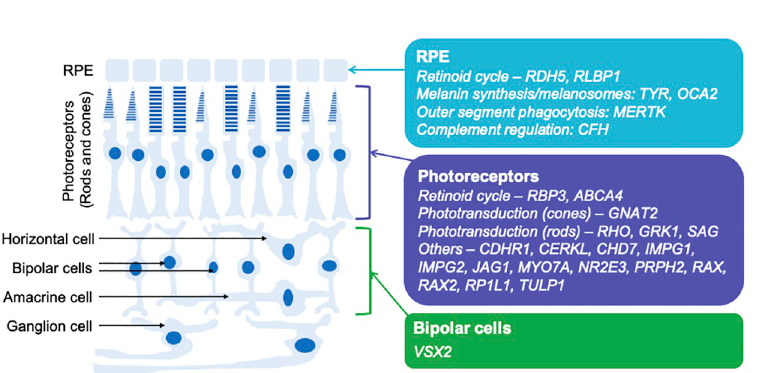
Fig 5. Schematic of retina showing main cell types with sites of expression (in mature human retina) of many of the genes associated with rare monogenic ocular disease found during genetic discovery (S5 Table). Some genes are also expressed significantly in other cell types not shown (e.g. RLBP1 is expressed also in Muller cells). Also, some genes (including those not shown within this figure) have a wider role in development, but expression is more restricted in adults (e.g. VSX2 is expressed in retinal progenitor cells in development, but mainly in bipolar cells in the mature retina).